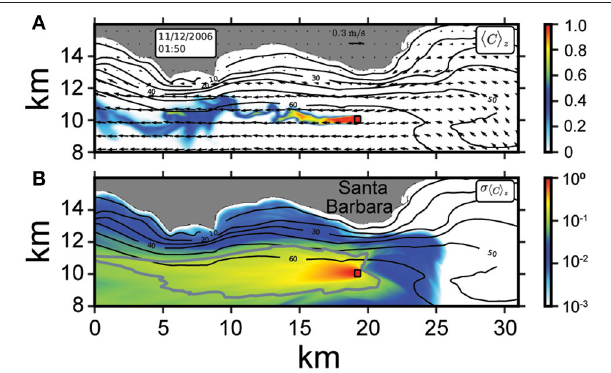
FIGURE 10 | Local effects of a 432 x 432 x 20 m farm demonstrated with a hindcast simulation of the Santa Barbara shelf with continuous release of a passive tracer ( C ) in the farm (denoted by thick black lines offshore of the 60 m isobath). (A) Instantaneous snapshot of vertically averaged tracer concentration ( h C i z , colors) and horizontal velocity (arrows, plotted every 805 m) in the upper 20 m. (B) Temporal root-mean square (over 10 days) farm “footprint” of the vertically integrated tracer ( σ h C i ). The 10 day period samples z various flow patterns with a primarily westward along-shore flow [see (A) ]. In (B) , the solid gray contour line denotes where farm effluent is 10% of the source. In both panels, the color-scale is normalized by the maximum value within the farm. Note the farm-drag induced wake vortices of the farm effluent (A) and approximate 20 km extent of the effluent footprint (B)